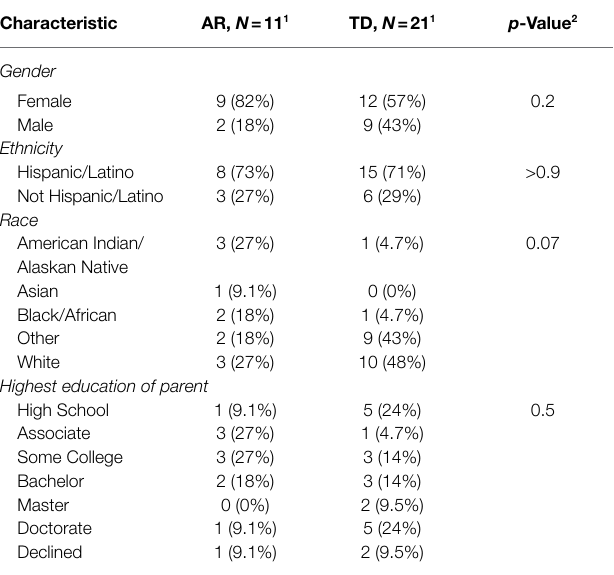
TABLE 2 | Demographic characteristics of participants (AR = at risk, TD = typical